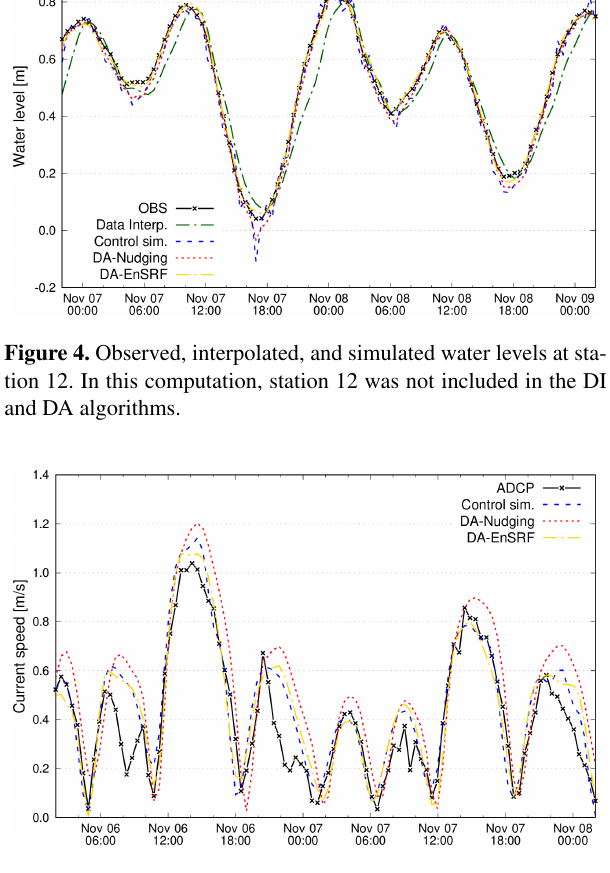
Figure 5. Observed and simulated vertically integrated current ve- locity at the Lido inlet. The ADCP was located close to tide gauge number 15.